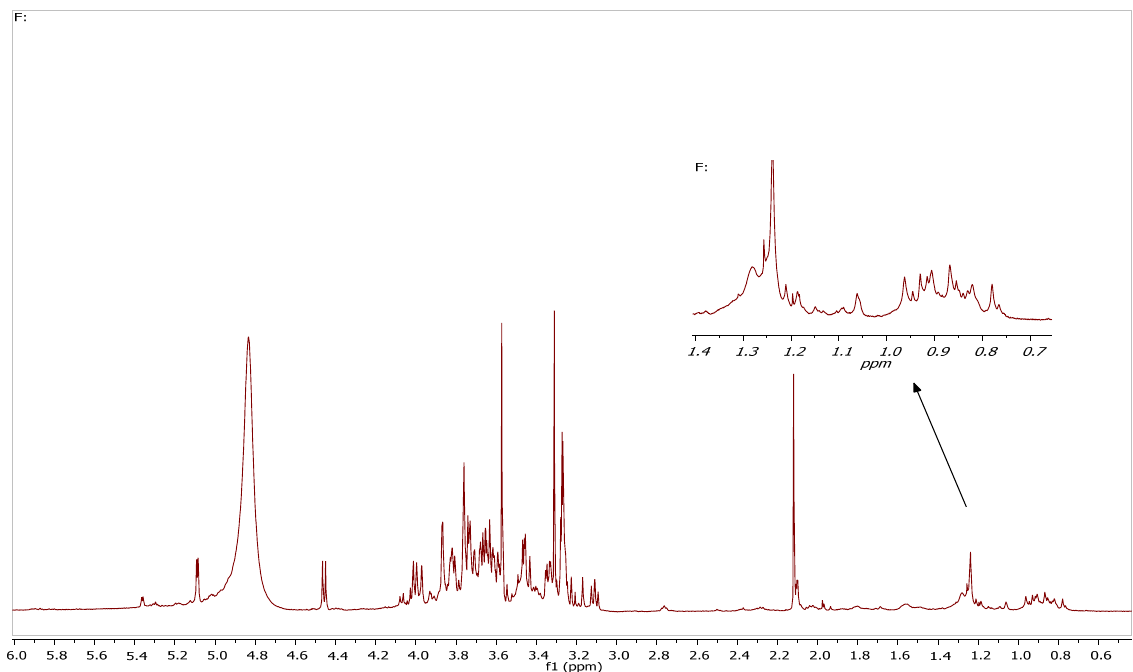
Figure 7. The 1 H-NMR spectrum for methanolic extract including sapiens.